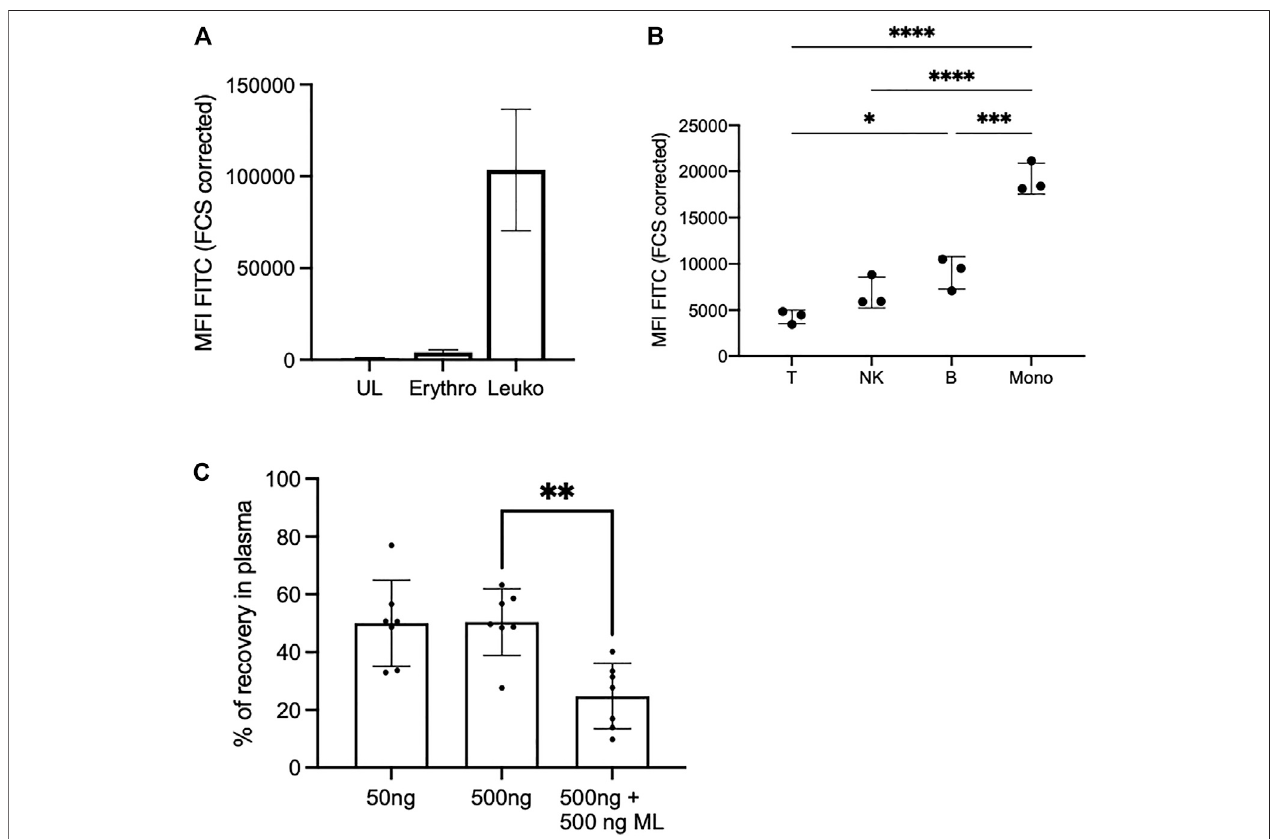
FIGURE 3 | In the blood, Bdpy-ML incorporates differently into cell populations and is largely found in plasma compartment. (A) Incorporation of Bdpy-ML as measured by FACS into erythrocytes (Erythro, CD235a+ cells) and leukocytes (Leuko, CD45 + cells) after 16 h of incubation in total human blood. Data are mean fl uorescenceintensities(MFI) ± SDnormalizedtocellsize(FCScorrected)oftriplicates. (B) IncorporationofBdpy-MLintoCD45 + bloodcells,includingTcells(T),NKcells (NK), B cells (B), and monocytes (Mono), after 16 h of incubation in total human blood. Data are mean fl uorescence intensities (MFI) ± SD normalized to cell size of replicatesfrom3donorsandarerepresentativesoftwoindependent experiments. Testone-wayAnova, * p < 0.1,*** p < 0.001,**** p < 0.0001 (C) RecoveryofBdpy-ML inplasmafractionasmeasuredbyspectro fl uorimetry,16 hafteradditionofeither50 ngor500 ngofBdpy-MLorof500 ngofBdpy-MLinpresenceof500 ngofnatural mycolactone(ML)intototalhumanblood. Dataareexpressedaspercentage ofrecoverycompared toplasmaspikedwiththesameconcentrationsofBdpy-ML andare means ± SD of 6